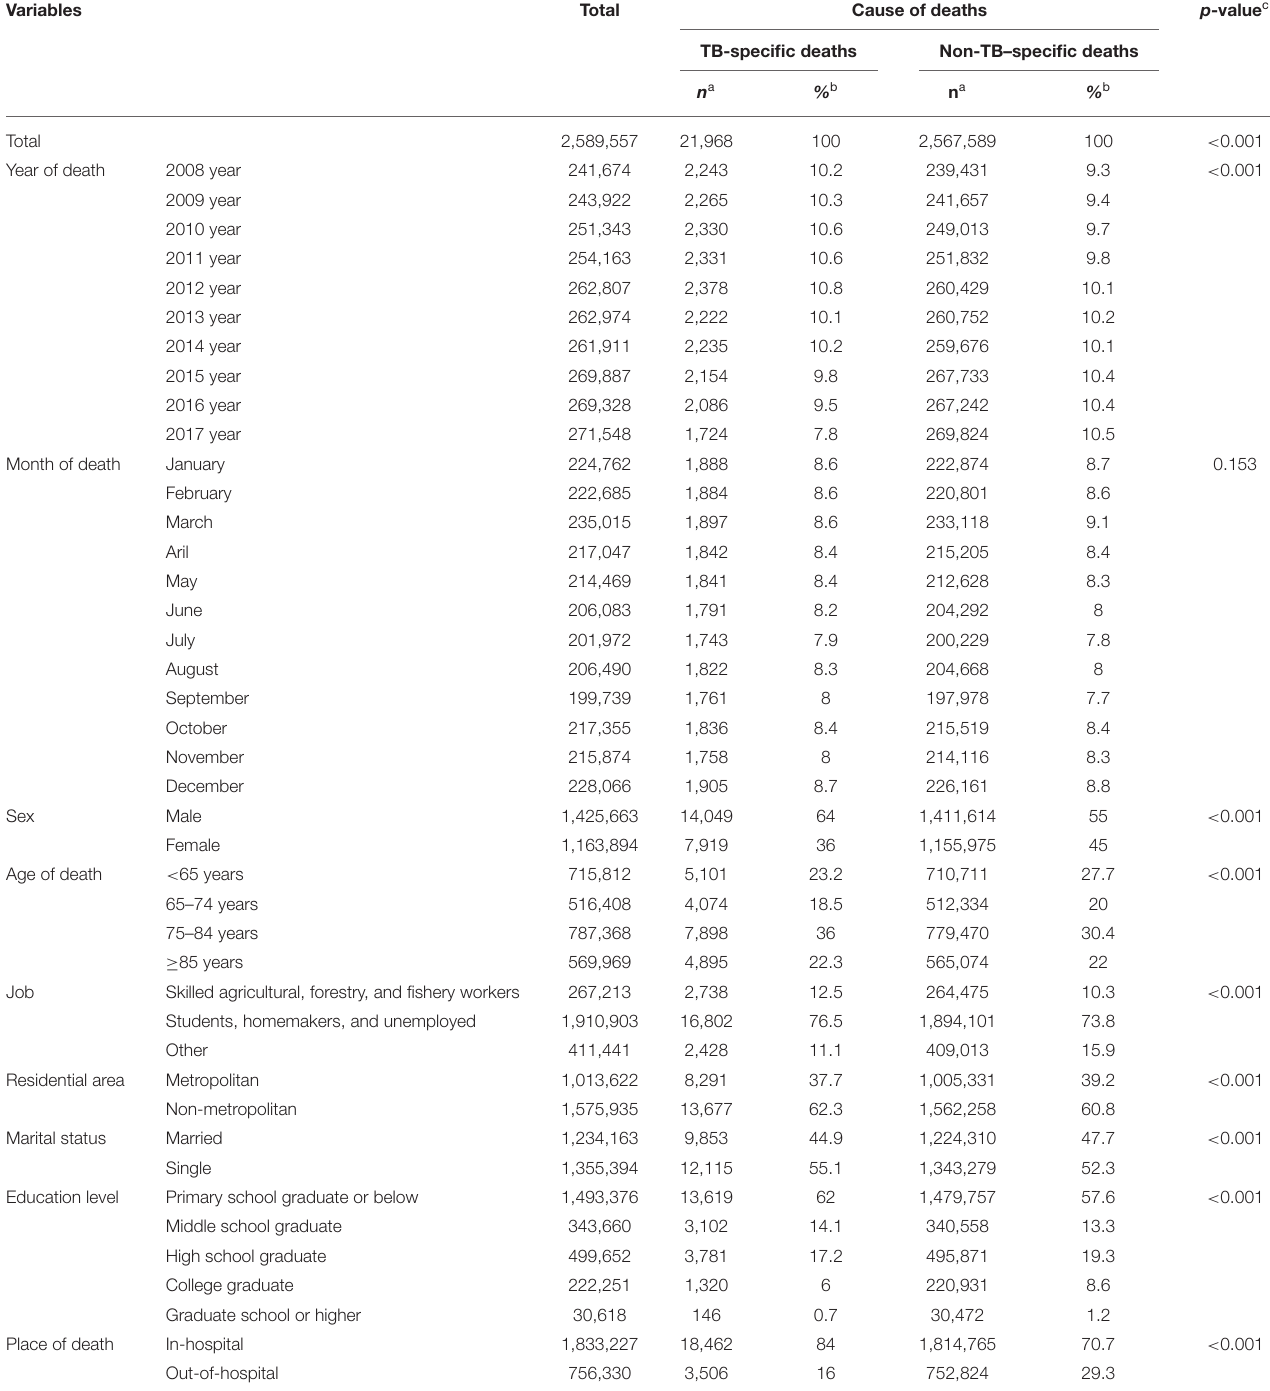
TABLE 1 | Socio-demographic factors of those with TB-specific deaths and non-TB–specific deaths. (Unit: